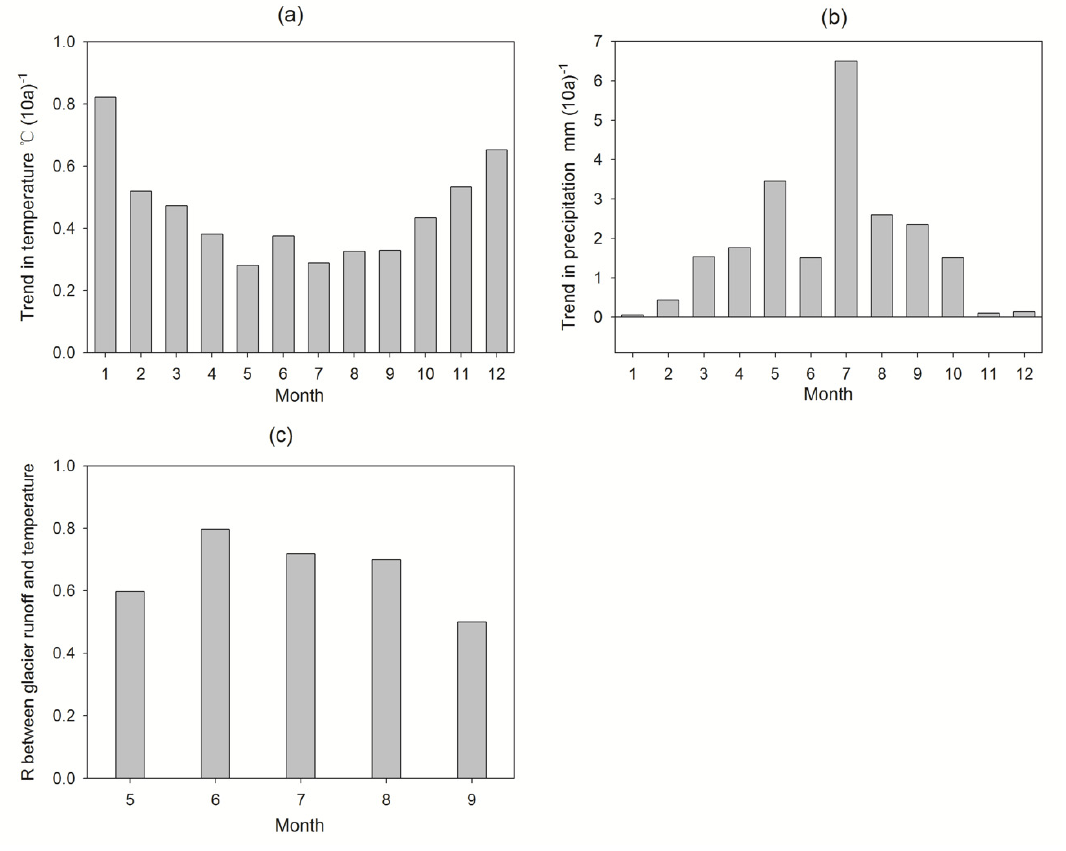
Figure 11. Trends of monthly temperature ( a ), precipitation ( b ), and Pearson correlation coefficient ( R ) between glacier runoff and temperature ( c ) in the UNRB.